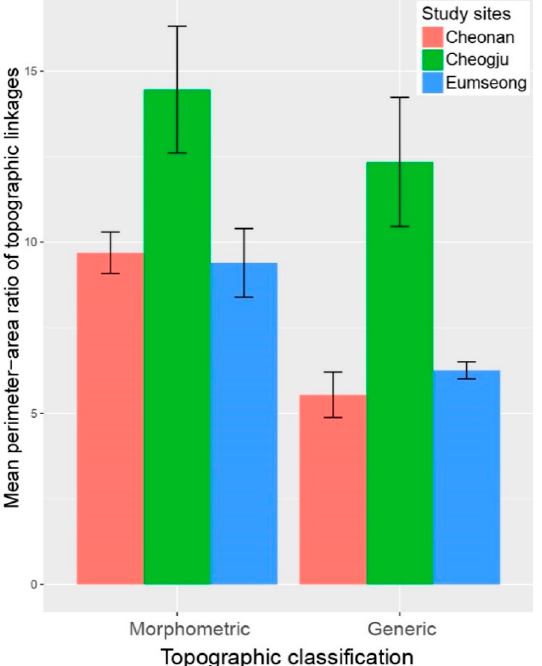
Figure 8. Mean perimeter-area ratio (P/A ratio) of morphometric and generic topographic linkages. The P/A ratio was higher in the morphometric classification than in the generic classification. A high P/A ratio indicates that the topographic linkage could be vulnerable to the edge effect.